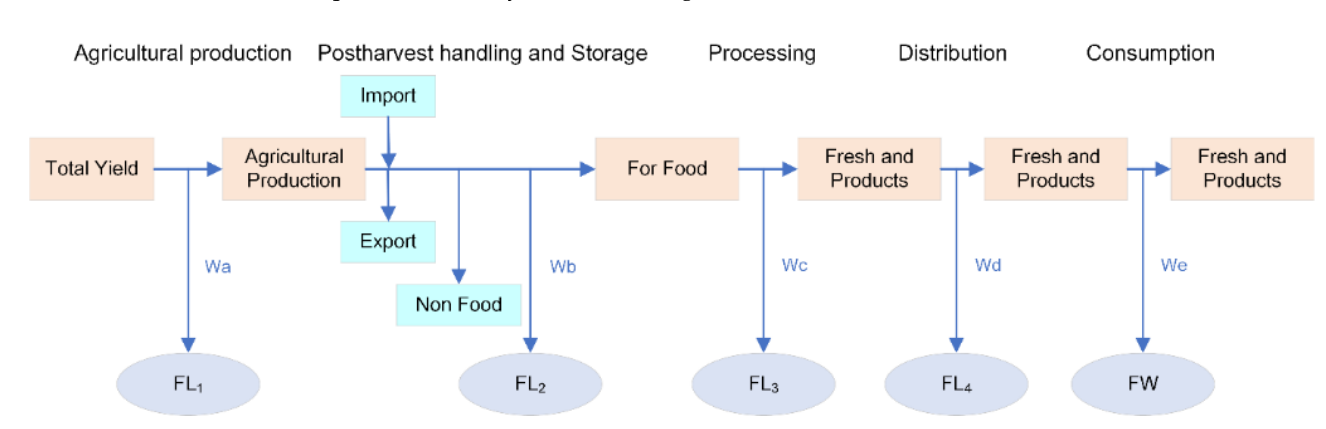
Figure 1. Accounting approach of the MFA. Figure 1.